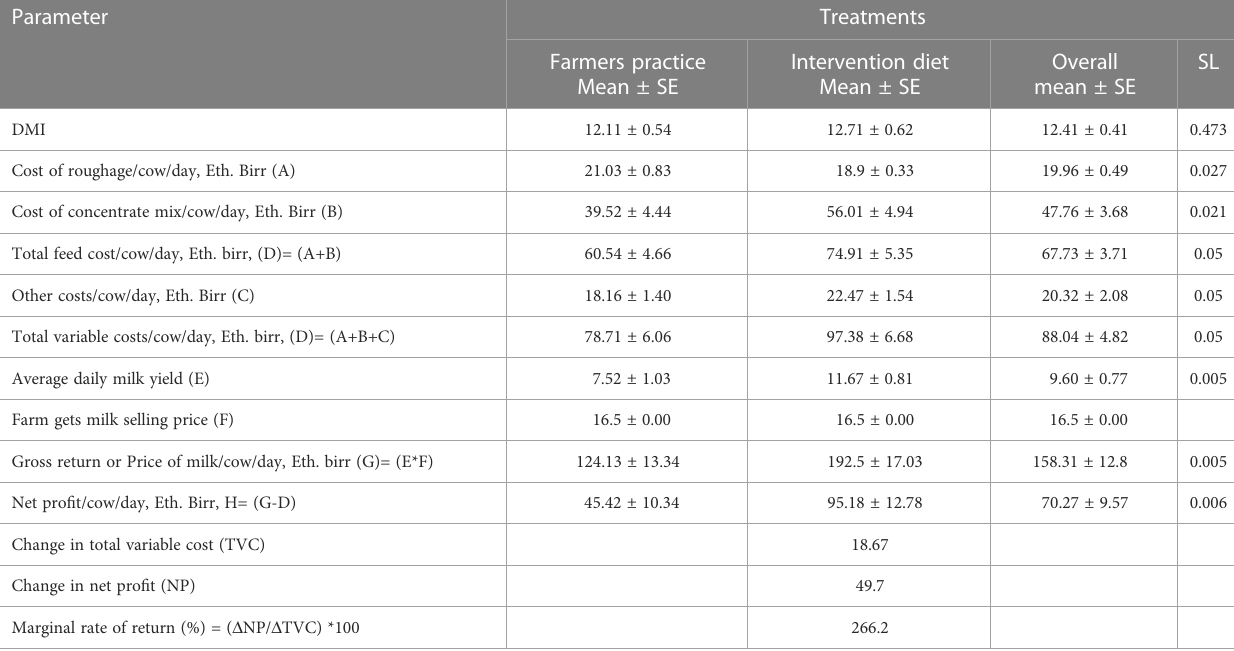
TABLE 4 Economic comparison of Intervention diet and farmers